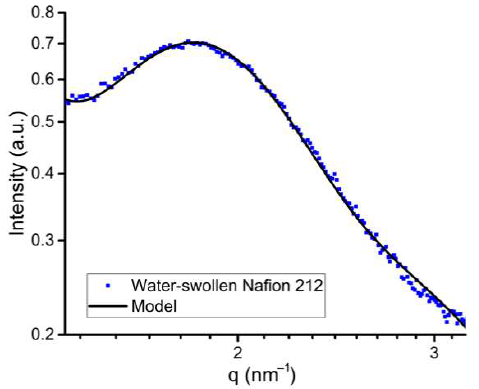
Figure 3. Experimental and model SAXS profiles in the ionic domain peak region.